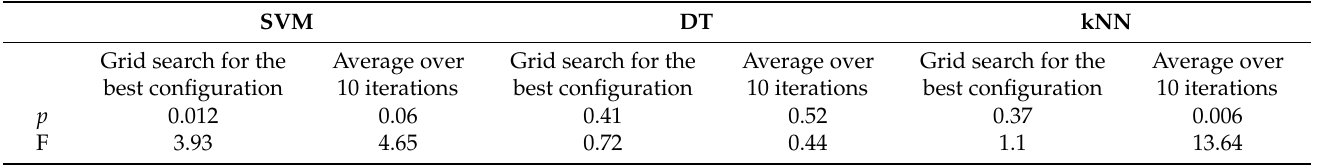
Table 16. p and F values for SVM, DT and kNN algorithms, overlapping dataset.